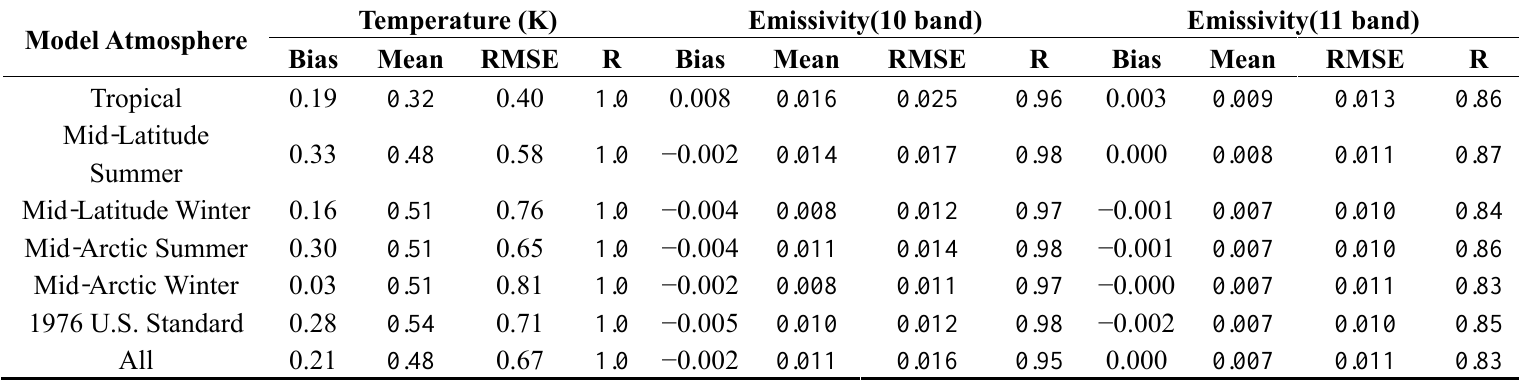
Table 3. Test results of the algorithm from the simulated data. Bias (the LST/LSE retrieved from the algorithm minus the reference LST/LSE), Mean absolute errors (Mean), RMSE values of the LST/LSE and linear correlation coefficient (R) are